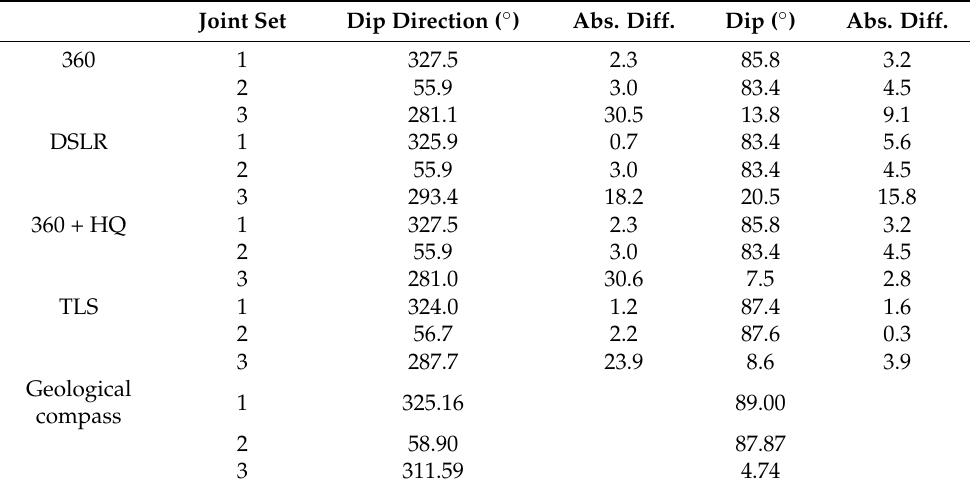
Table 6. Comparison of the mean orientation of discontinuity sets extracted from the 3D models using the semi-automatic method by [2], and manual compass